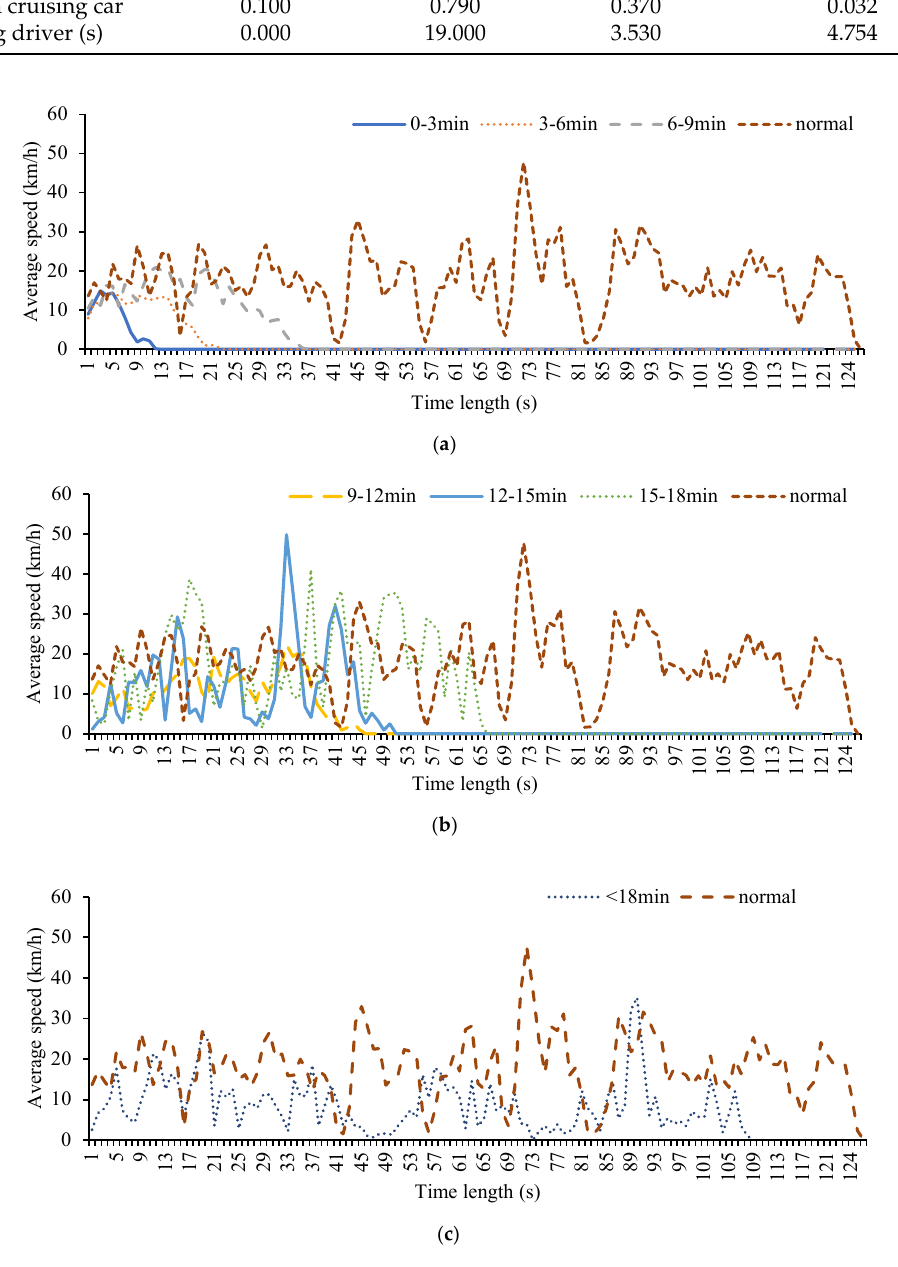
Figure 2. Comparing the average speed of cruising vehicles with normal vehicles speed under different cruising times. ( a ) Cruising time ranging from 0 to 9 min. ( b ) Cruising time ranging from 9 to 18 min. ( c ) Cruising time less than 18 min.